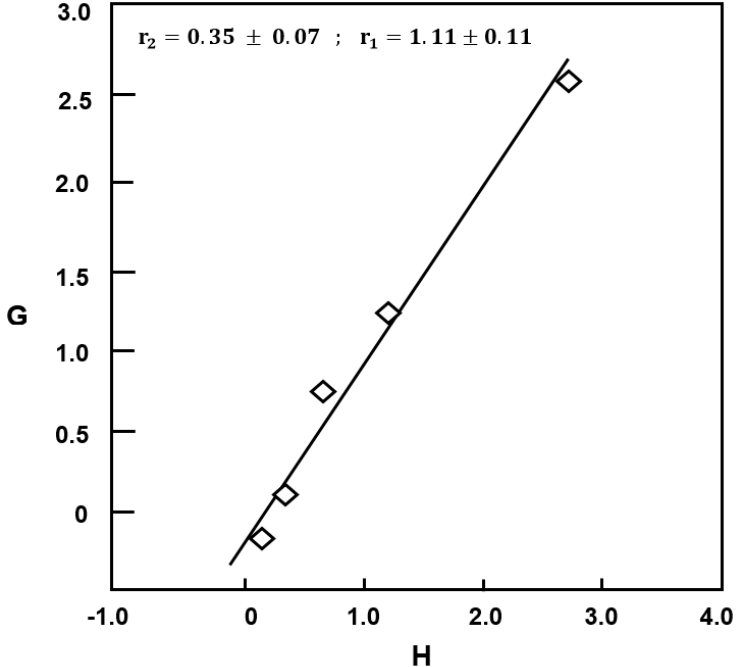
Figure 10. Fineman–Ross plot indicating variation of G vs. H for copolymerization of EUGMA with MMA.